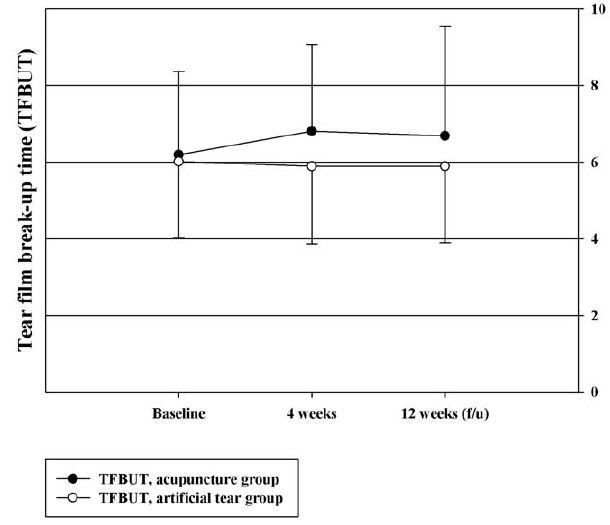
Figure 4. Tear film break-up time (TFBUT).